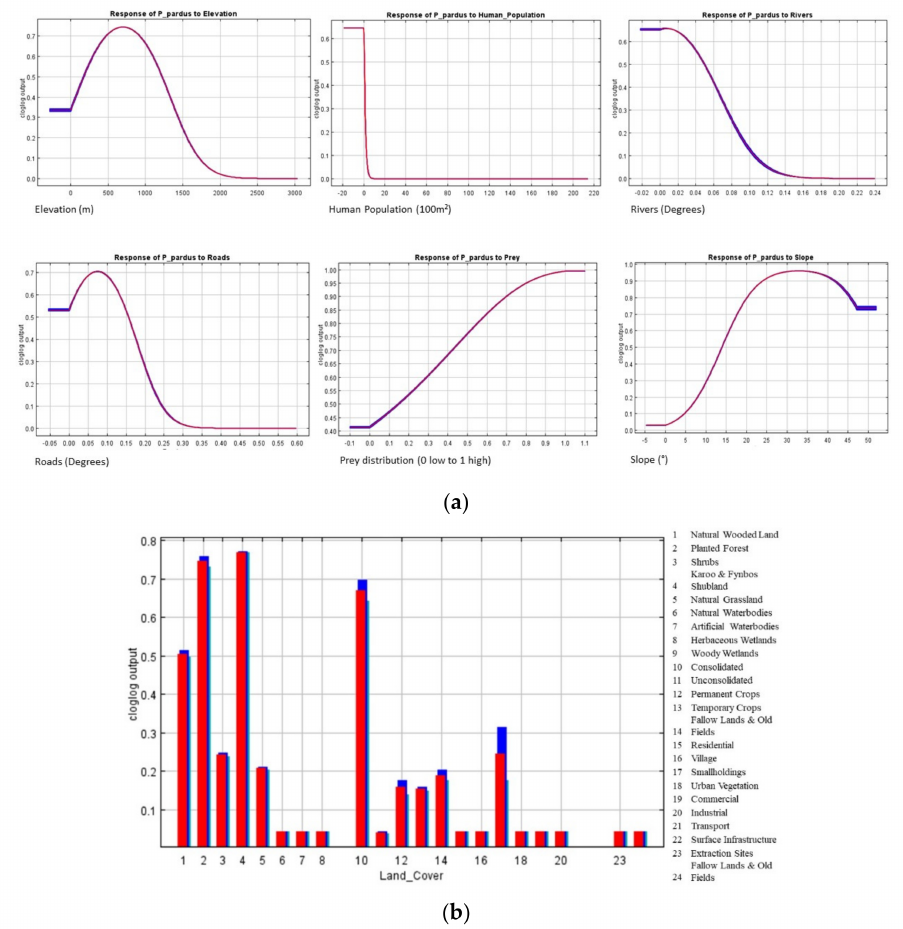
Figure A5. ( a ) Leopard probability of selection response curves for each environmental covariate used in the full habitat prediction model: elevation (m), human population density (100 m 2 ), distance to rivers (degrees), distance to roads (degrees), prey distribution (0 low to 1 high), slope (degrees) and ( b ) land-cover